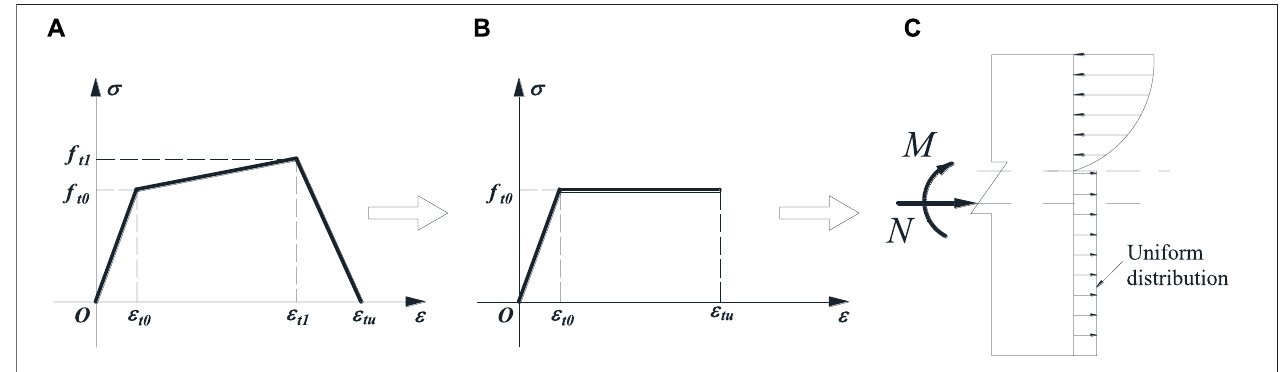
FIGURE 1 | Simpli fi cation of ECC stress distribution in the tensile zone. (A) Trilinear model for the tensile stress-strain relationship of ECC. (B) Simpli fi ed bilinear model for the tensile stress-strain relationship of ECC. (C) Uniform distribution of the stress in tensile zone.